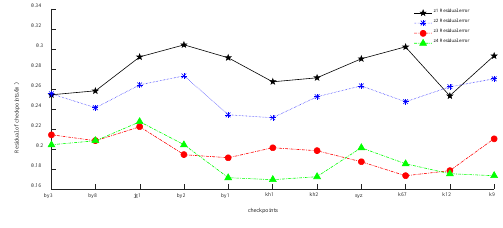
Figure 11. Contrast analysis diagram of Z- direction residual